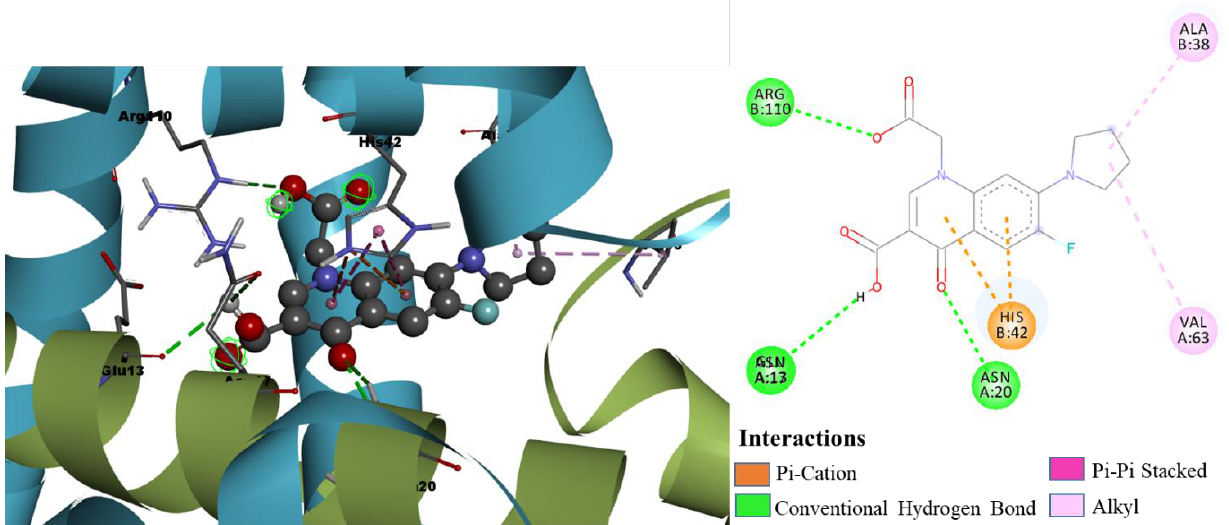
Figure 9. Binding mode conformation and molecular interactions of compound 7b in the active site of S. epidermidis TcaR. The left and right figures represent the molecular interactions in 3D and 2D, respectively. The compound 7b is shown in the ball-stick model, and the key interacting residues are shown as grey sticks.